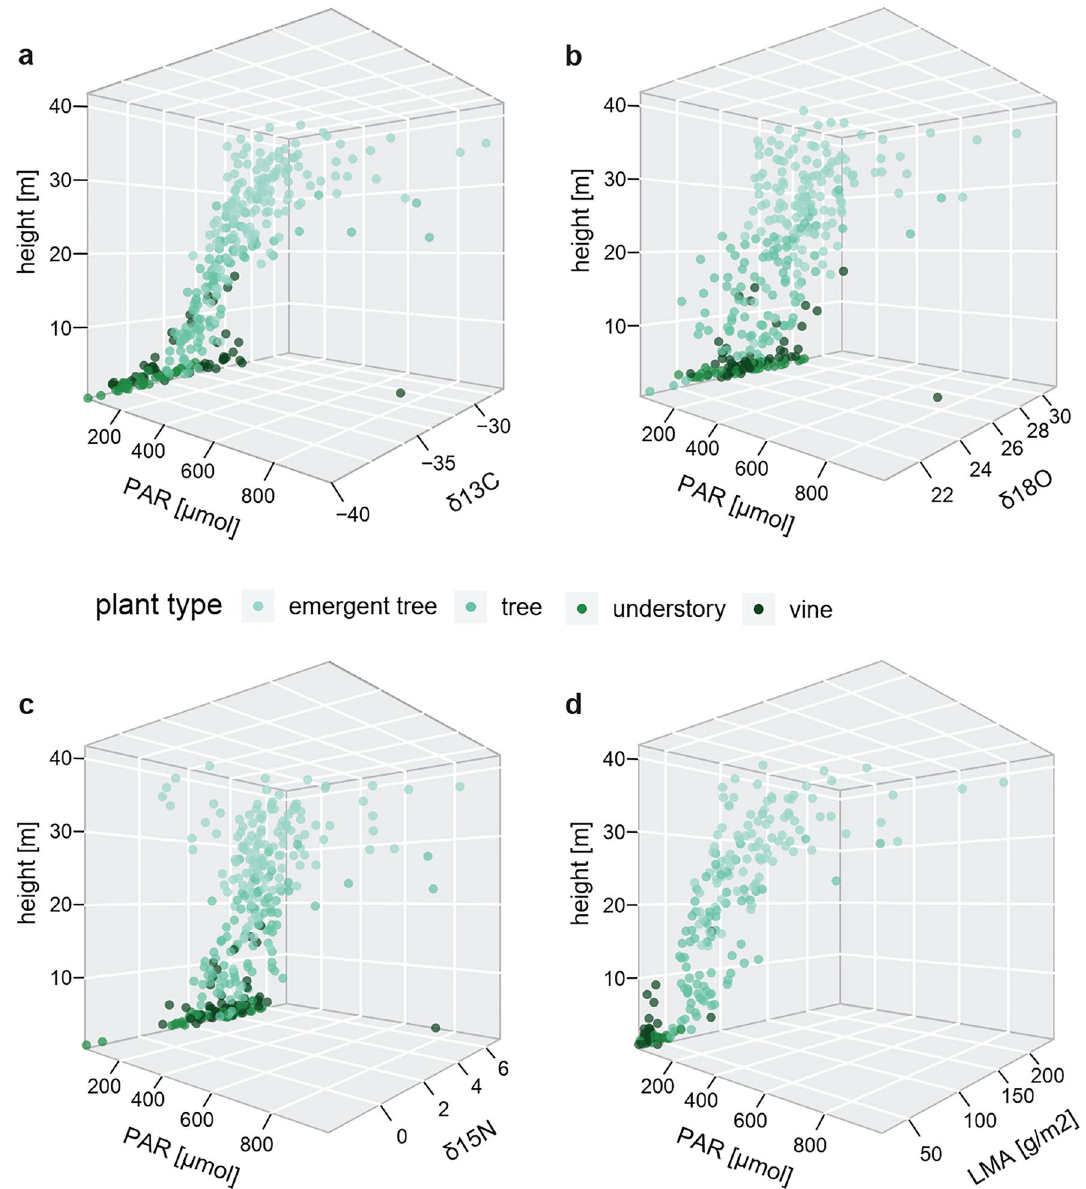
m −2 s −1 . Different data point colors relate to different plant types within the plants sampled in this study. The single outlier data point from the vine species Landolphia foretiana (Lan.2.1) was excluded from our statistical data